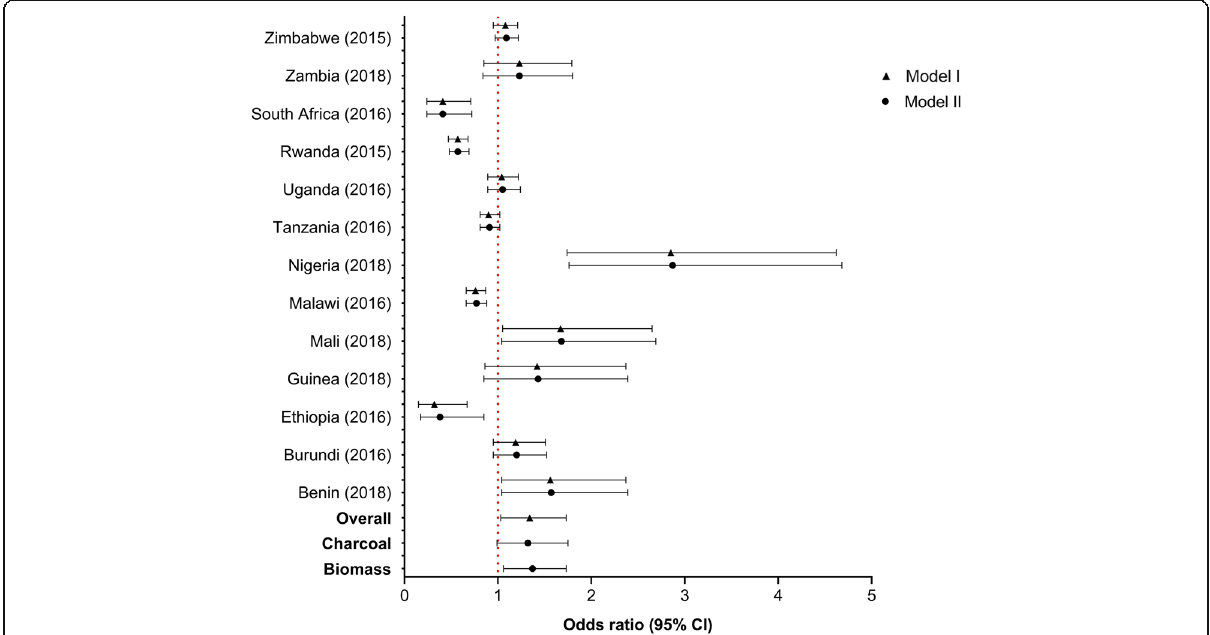
Fig. 2 Association between HAP exposure and under-five mortality. Angola used as reference